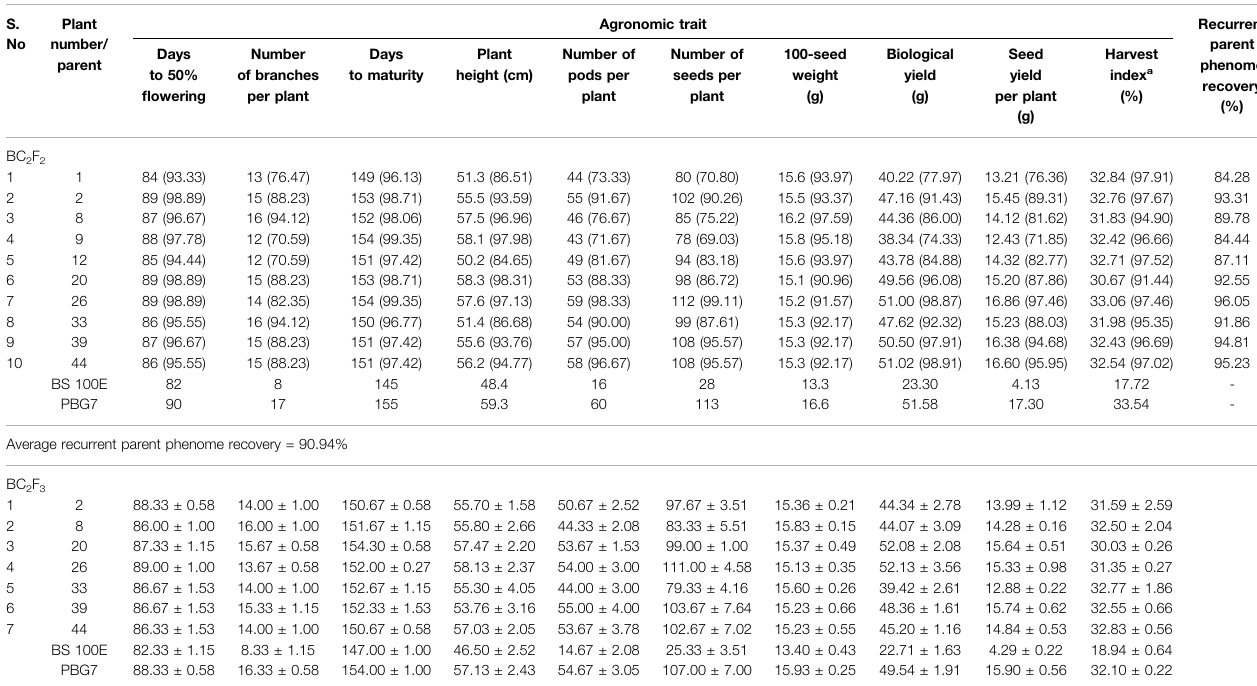
DataonBC 2 F 2 populationarepresentedfortheplantsanalyzedforrecurrentparentgenomerecovery;DataonBC 2 F 3 populationarebasedonthreeplantsphenotypicallysimilartoPBG7 and presented as mean ± SD; fi gures in parentheses are recurrent parent recovery percentages for agronomic traits calculated as plant trait value/value of PBG7 for that trait × 100.